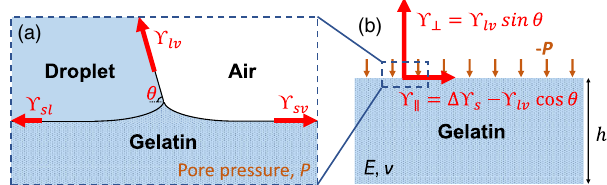
FIG. 2. A schematic diagram showing the forces acting on the gelatin. (a) Near the contact line, there is a highly deformed wetting ridge. The gelatin may also be deformed by a pore pressure P that acts to swell or deswell the gelatin. (b) At a scale much bigger than that of the wetting ridge, the surface forces and pore pressure effectively act as horizontal and vertical line forces at the contact line, and as a uniform compressive pressure on the surface of a flat film.